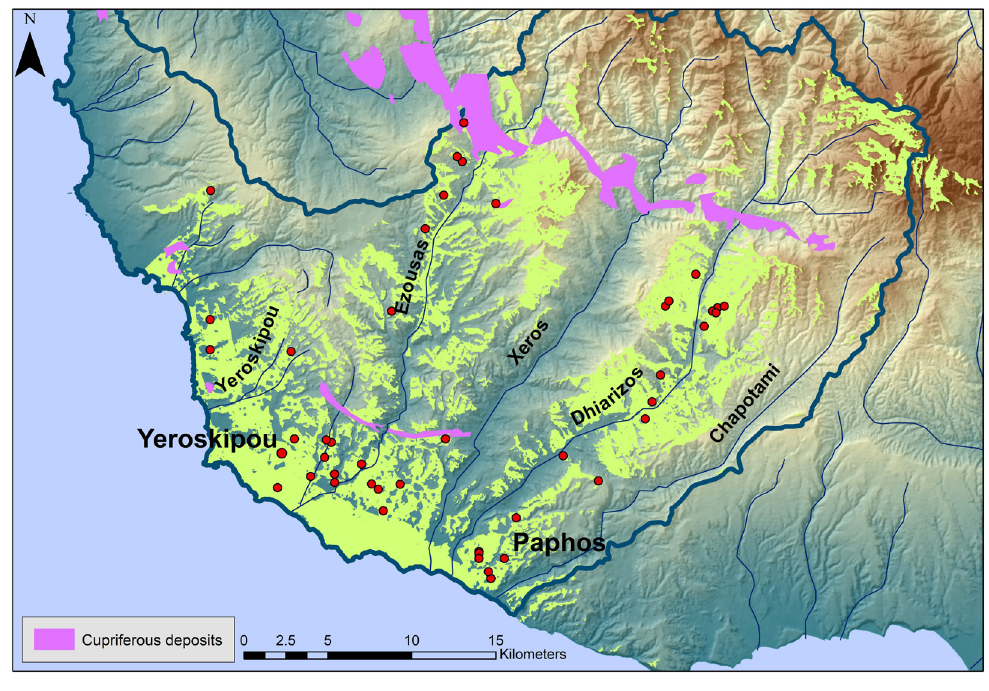
Figure 11. Site distribution in the hydrological basin of Paphos in MCIII/LCI with cumulative view-shed area from all sites high- lighted with yellow colour; areas not highlighted are not visible from the sites. Drafted by A. Agapiou